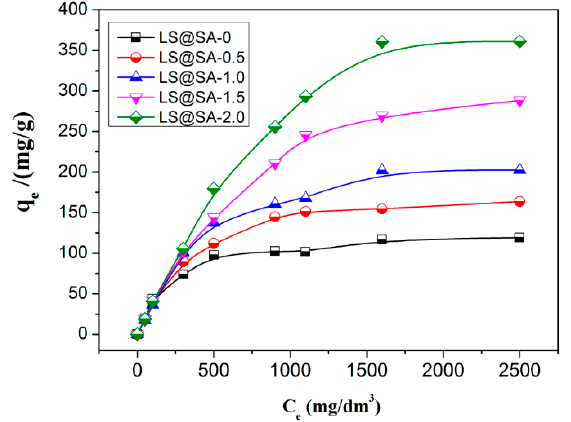
Figure7. E ff ectoftheMBconcentrationofsolutionontheadsorptioncapacityofadsorbents. Adsorption Figure 7. Effect of the MB concentration of solution on the adsorption capacity of adsorbents. experiments, pH: 6.50; and equilibrium time: 600 Adsorption experiments, pH: 6.50; and equilibrium time: 600 min.